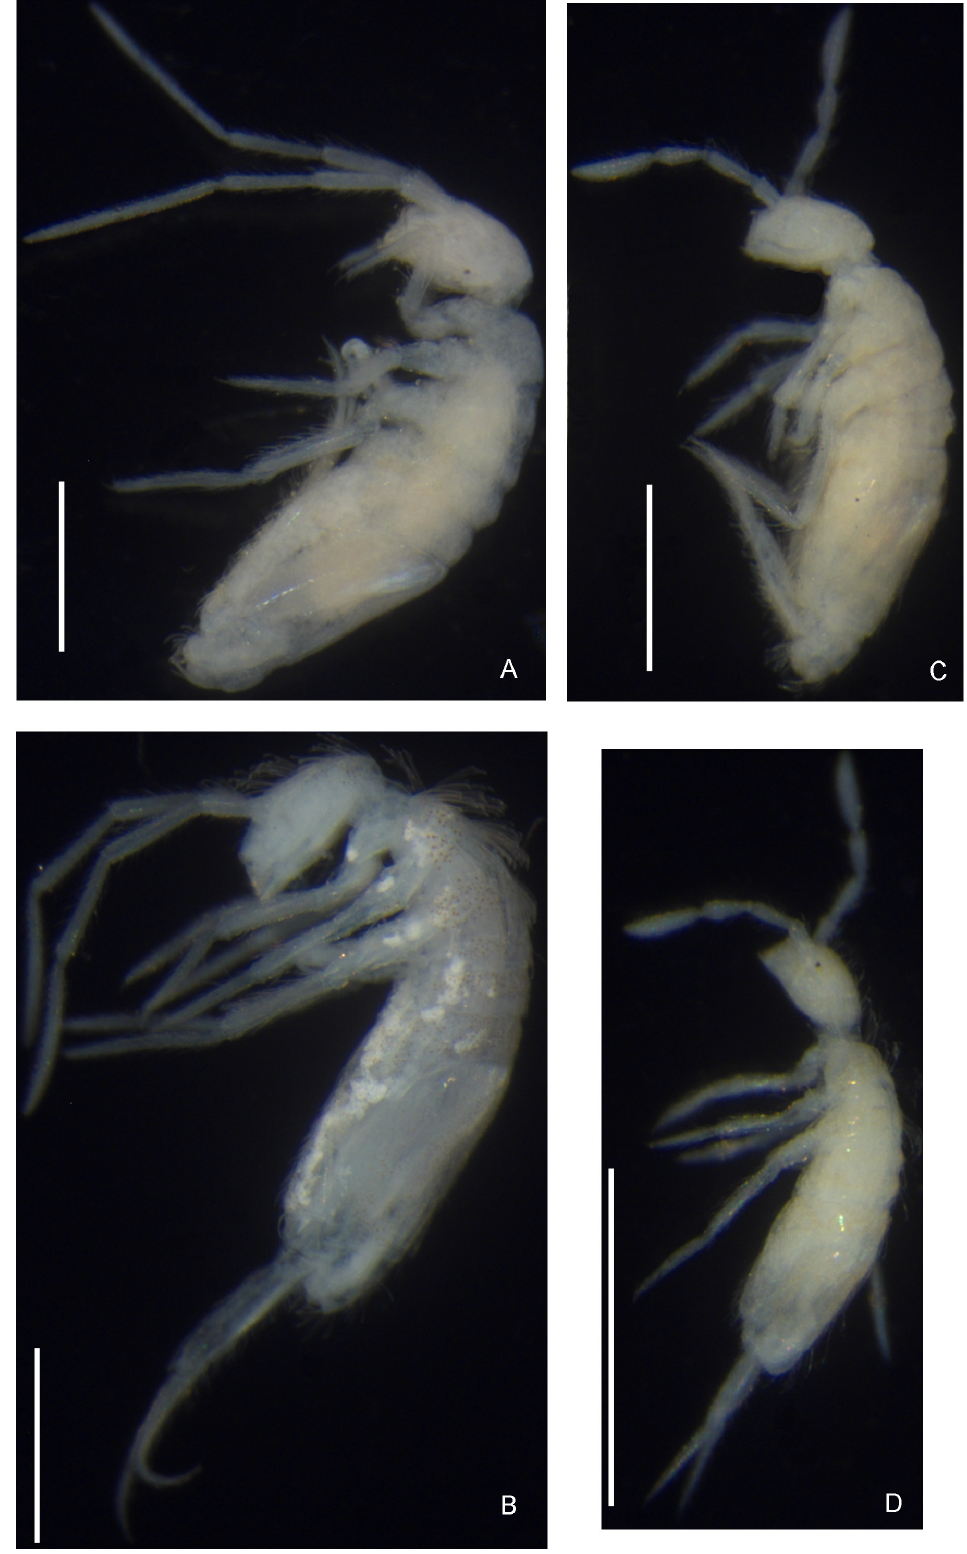
Fig. 1. Habitus. A . Coecobrya gejianbangi sp. nov. B . Coecobrya annulata sp. nov. C . Coecobrya ciliata sp. nov. D . Coecobrya oculata sp. nov. Scale bars: 500